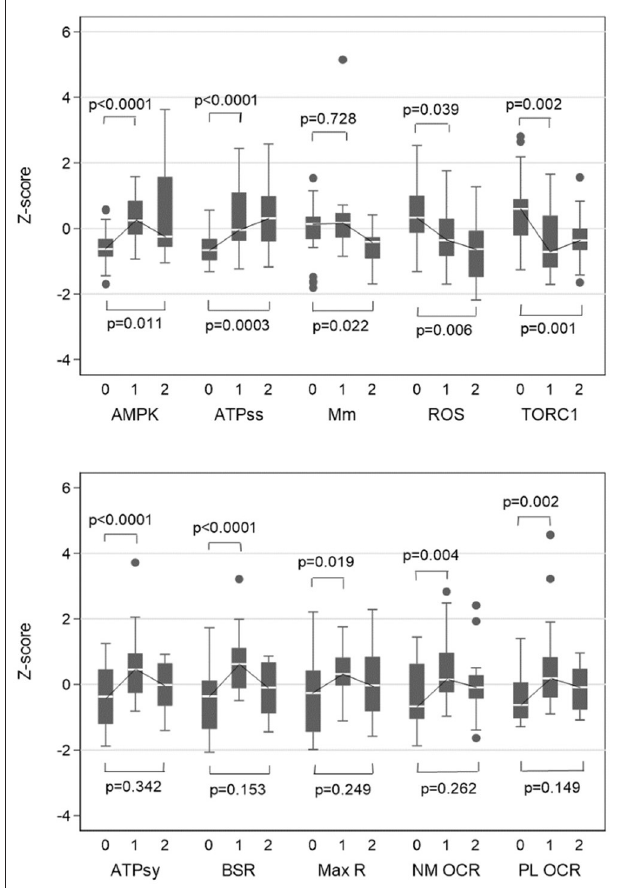
FIGURE 1 | Box plots of Z-scores of biochemical variables for controls vs. Non-FXTAS and controls vs. FXTAS. 0, controls; 1, Non-FXTAS PM; 2, FXTAS; AMPK, Relative AMPK activity; ATPss, ATP steady state level; Mm, Mitochondrial mass; TORC1, TORC1 activity; ATPsy, ATP synthesis; BSR, Basal respiration rate; Max R, Maximum respiration; NM OCR, Non-mitochondrial ATP OCR; PL OCR, Proton Leak OCR. Z-score for BSR and TORC1 were adjusted for age, while ATPsy was adjusted for age and gender. Standardized measures (z-scores) for each variable were computed (for illustrative purpose only) using individual scores summed up over all three subgroups (data) according to the formula: z-score, (data-mean(data))/SD